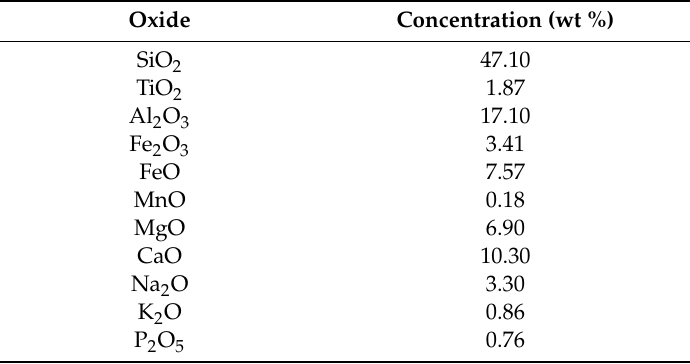
Table 1. Chemical composition of the oxides in JSC-1A simulant